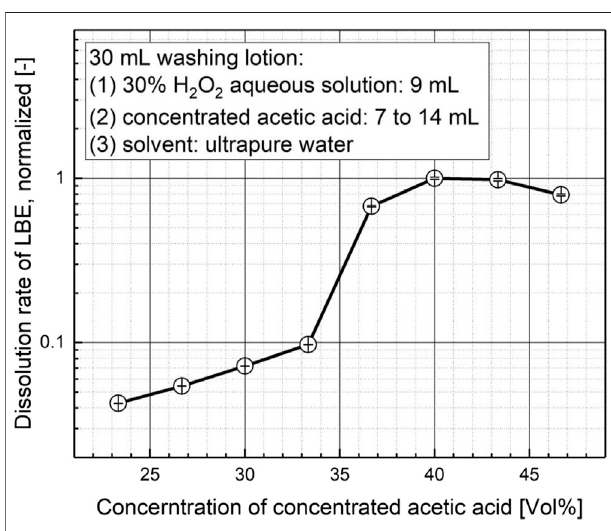
Frontiers in Energy Research |